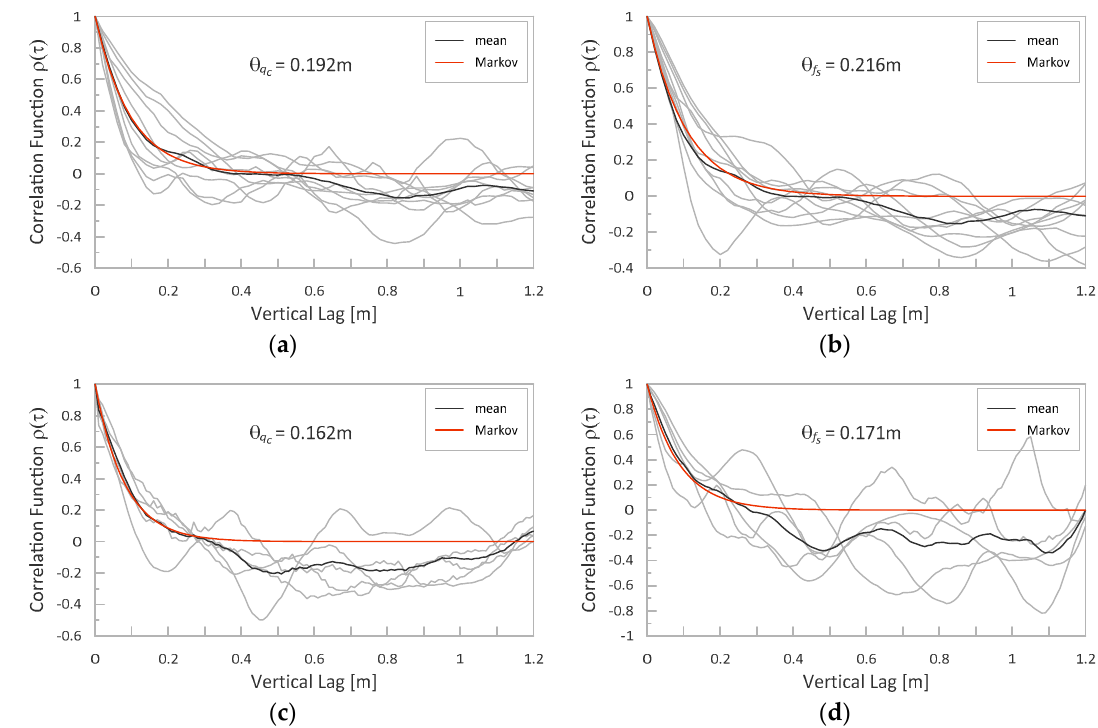
Figure 14. Vertical SOF obtained in analyzed case studies: ( a ) Ś wierzna clay-SOF for q c ; ( b ) Ś wierzna clay-SOF for f s , ( c ) Keswick clay-SOF for q c ; ( d ) Keswick clay-SOF for fs.